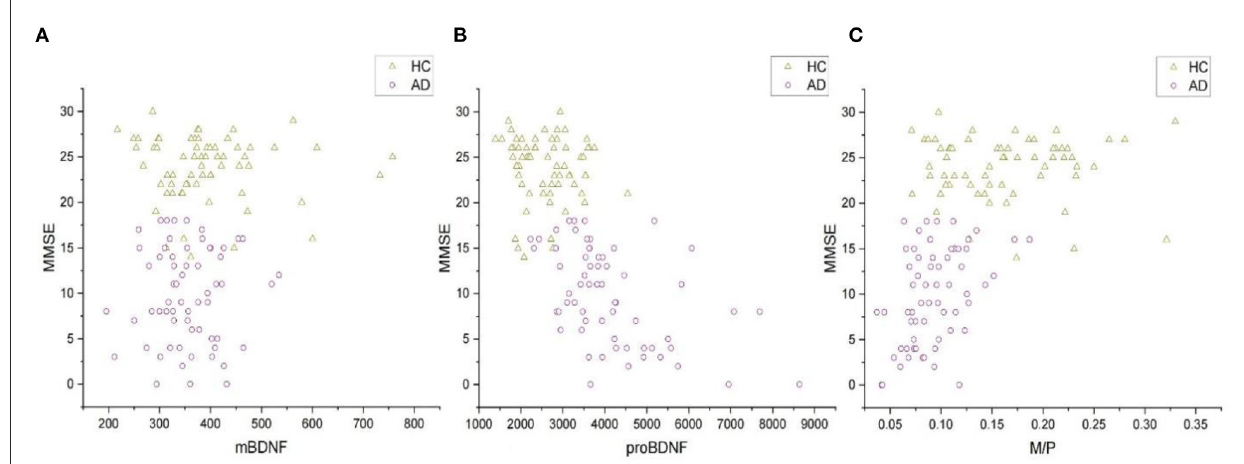
FIGURE2 The correlations of MMSE and serum mBDNF, proBDNF, and M/P levels in all subjects. (A) The correlation between mBDNF and MMSE. (B) The correlation between proBDNF and MMSE. (C) The correlation between M/P and MMSE. All the data were analyzed by Spearman’s correlation test. mBDNF, mature brain-derived neurotrophic factor; proBDNF, the precursor of brain-derived neurotrophic factor; M/P, the ratio of mBDNF levels to proBDNF levels; MMSE, Mini-Mental State Examination.